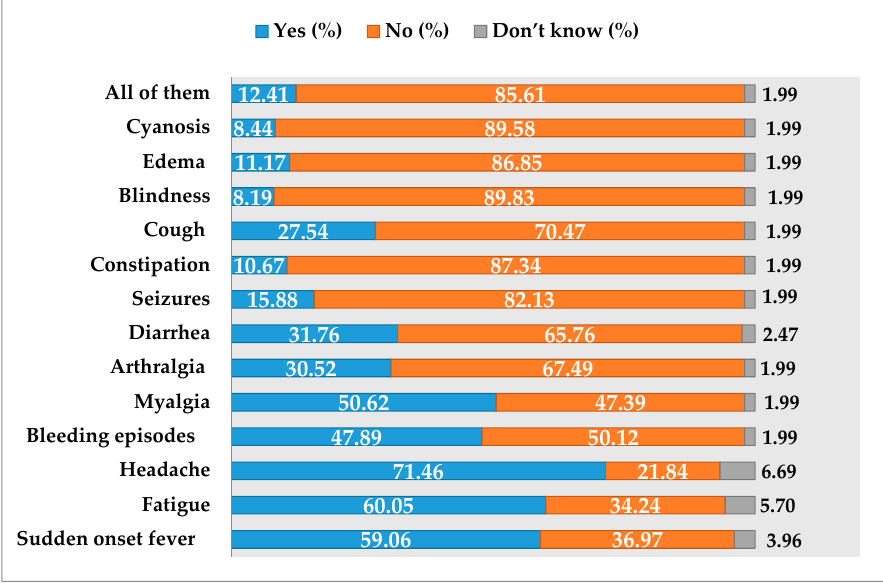
Figure 3. Respondents’ beliefs about symptoms of EVD.